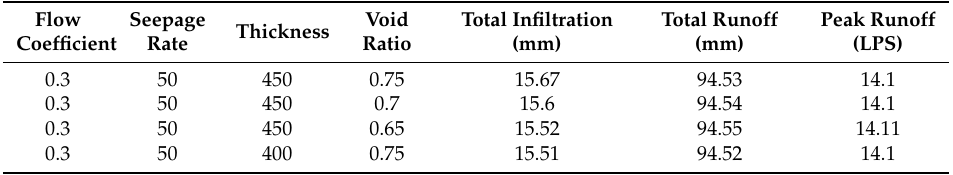
Table 4. Results of the simulated scenarios for the low-impact development (LID) design parameters (step 7 of the WMAM).